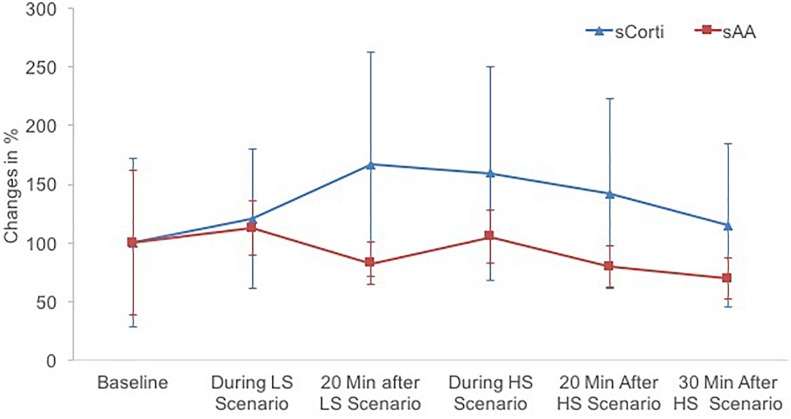
Physiological response profiles to the low stress (LS) and high stress (HS) scenario regarding mean salivary cortisol (sCorti) and mean salivary alpha-amylase (sAA). Error bars represent standard deviation.